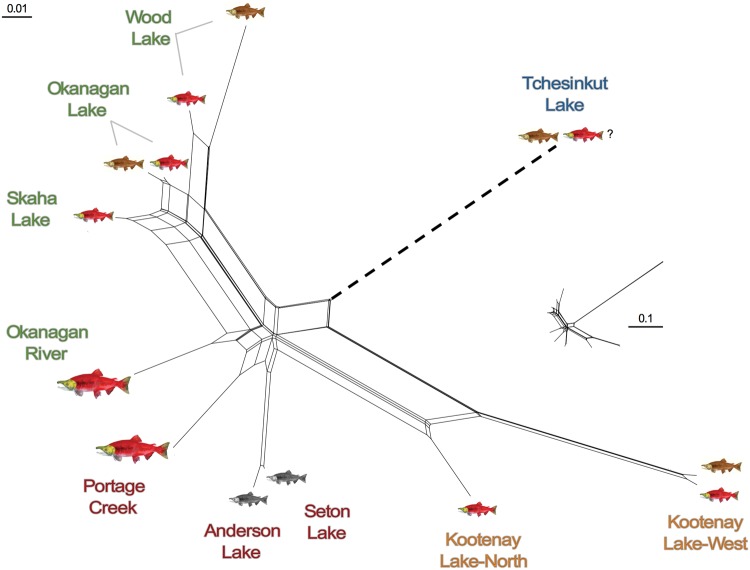
—Two-dimensional NeighbourNet (Bryant and Moulton 2004) population network based on FST (Weir and Cockerham 1984) calculated using genotypic data at 6,234 neutral SNPs. The length of the Tchesinkut lake branch is shortened to enable a better comparison of the other branches; the relative length of the whole network shown inset. Size and color of Oncorhynchus nerka images as in figure 1. Color of the text for each place name denotes drainage (green = Columbia River, red = Fraser River, blue = Skeena River). Kootenay Lake kokanee may potentially be historically linked to either the Columbia or Fraser drainages, and indicated in orange.